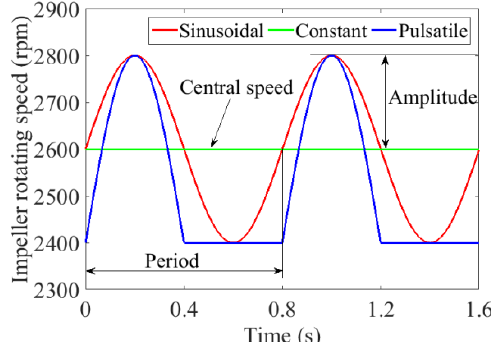
Figure 8. Amplitude and frequency characteristics of the three kinds of speed patterns of a blood pump impeller. The central speed was the same as that of the constant speed pattern, which was also the reference speed of the sinusoidal speed pattern.